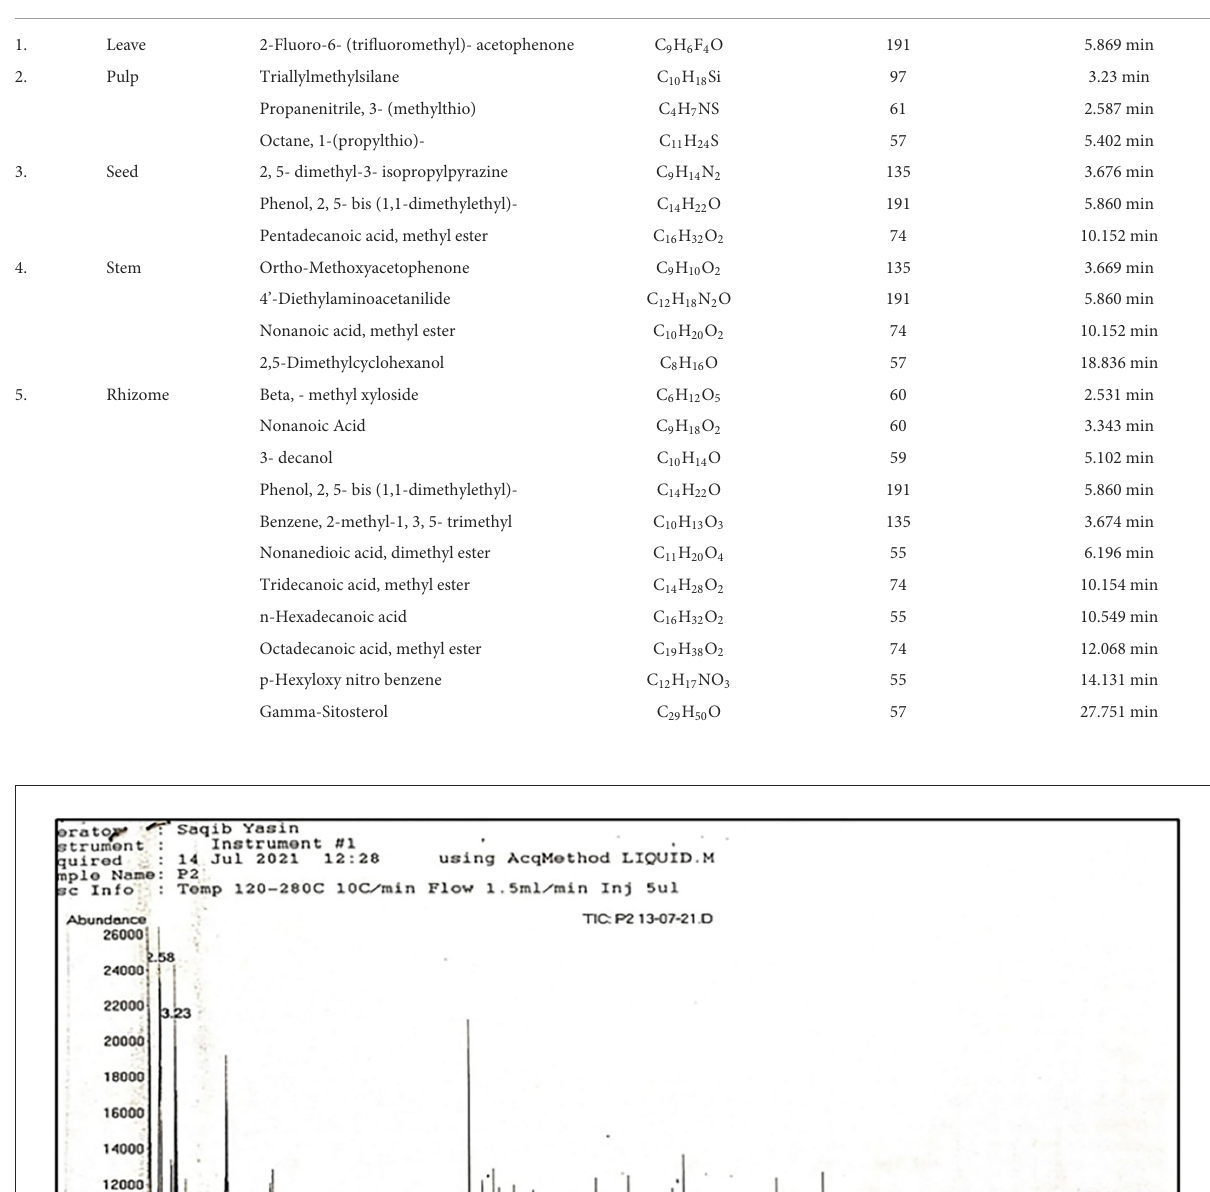
TABLE 1 GC-MS analysis and characterization of different compounds in various parts of A. jacquemontii Blume. Sr. No.